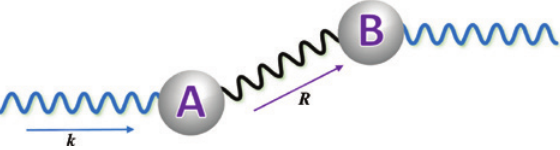
Figure 1: Optical binding between nanoparticles A and B separated by a displacement vector R . Identical input and output photons of wave vector k are depicted in blue, a virtual photon in